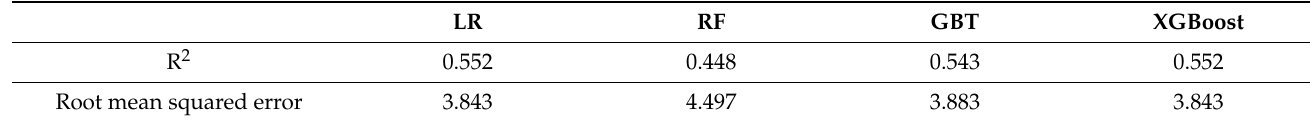
Table 4. Results of regression